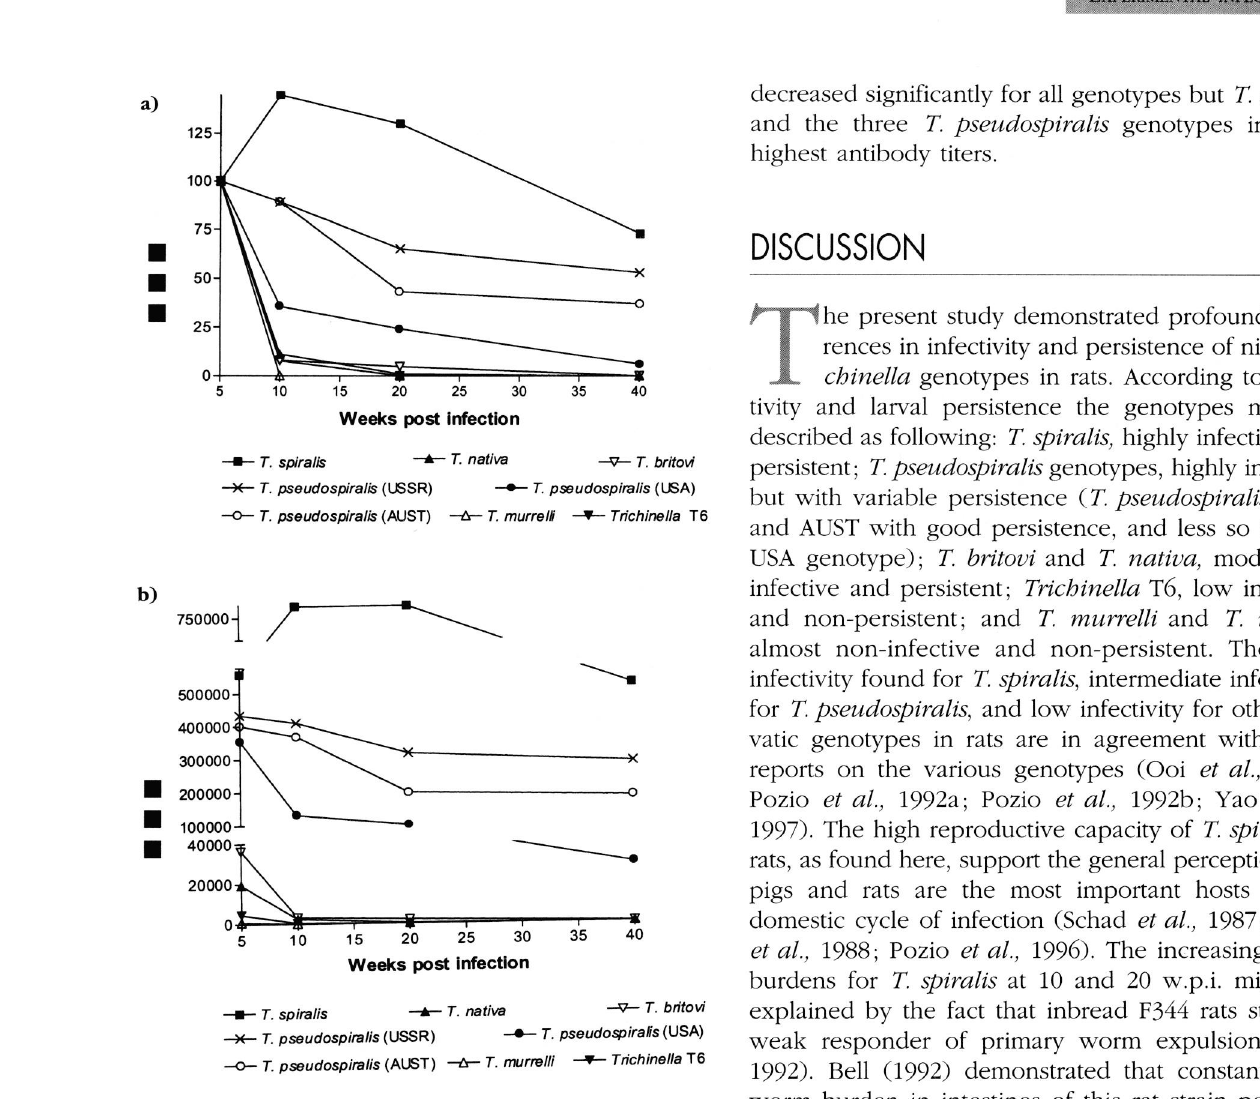
Fig. 1a+b. - Larval intensity (a) and total larval burden (b) of nine Trichinella genotypes in rats 5, 10, 20, and 40 weeks post infec tion.